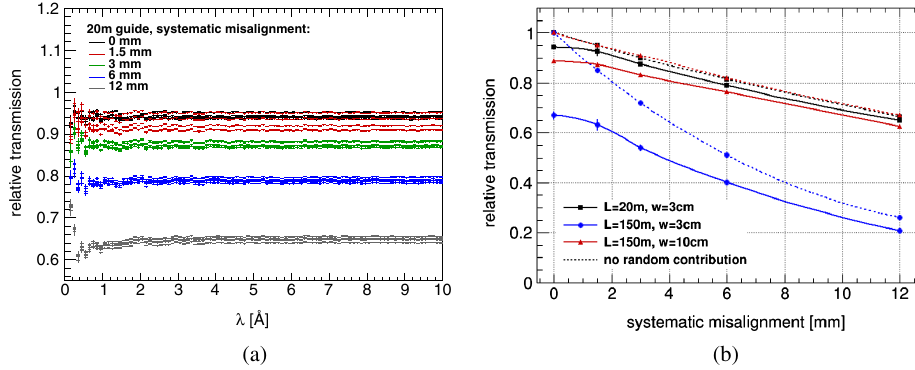
FIG. 2. Relative transmission with respect to perfectly aligned guide with different amounts of a systematic vertical misalignment. Guide sections are 1 m long. (a) Relative transmission of a 20 m guide with 3 × 3 cm 2 cross section as a function of wavelength, with systematic misalignment as well as 50 μ m random misalignment both horizontally and vertically. Error bars show the statistical uncertainty of the simulation only, the statistical uncertainty of the random misalignment is exemplary indicated by five different simulations with five different random numbers for the random misalignment. (b) Relative transmission as a function of maximal systematic misalignment with (solid) and without (dotted) additional 50 μ m random misalignment, for different guide lengths L and widths w . Systematic misalignments of 0, 1.5, 3.0, 6.0 and 12.0 mm are simulated; the lines are a guide for the